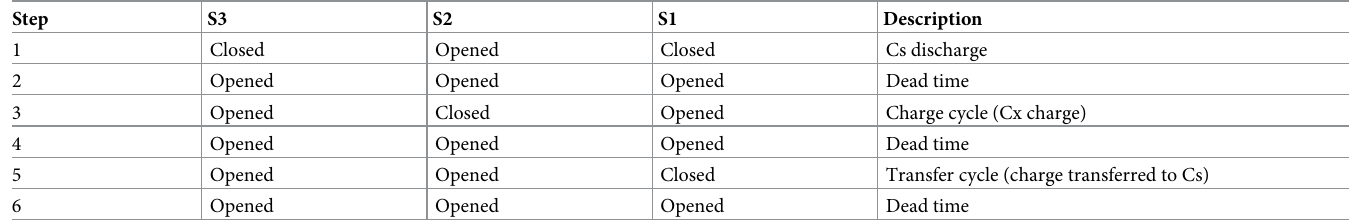
Table 1. Switching steps of the capacitive sensing principle.